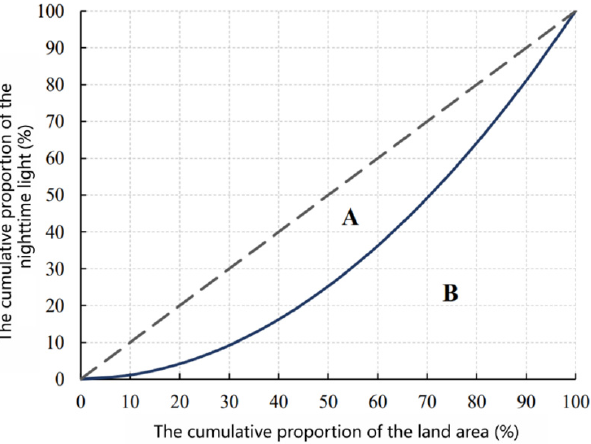
Figure 4. The Lorenz curve for calculating the Unbalanced Index of Night-time Light (UINL).